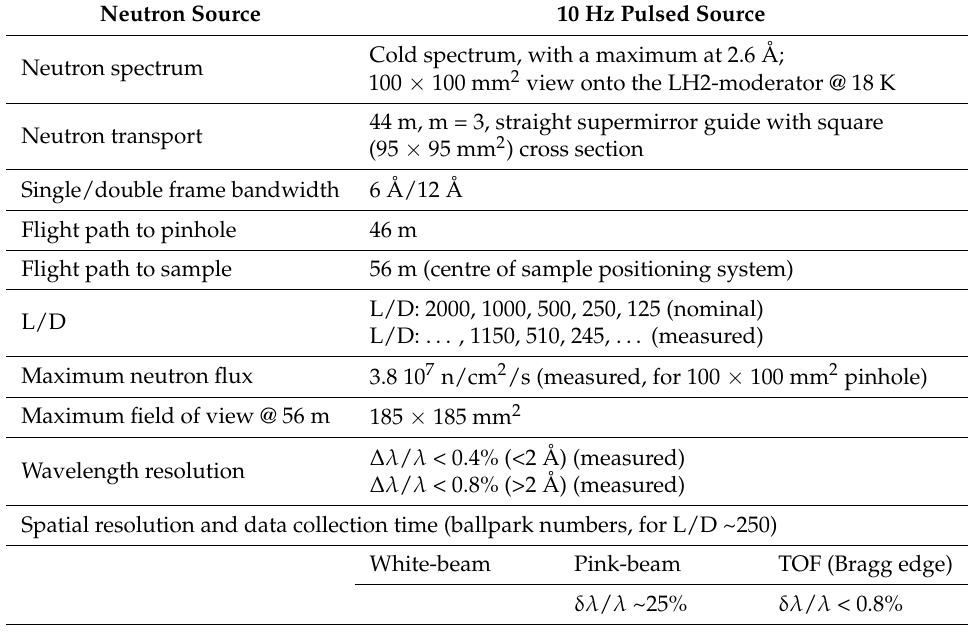
Table 3. IMAT instrument parameters for TOF imaging. Performance parameters are taken from [29]. Estimated resolution and counting times refer to radiography (2D) and tomography (3D)